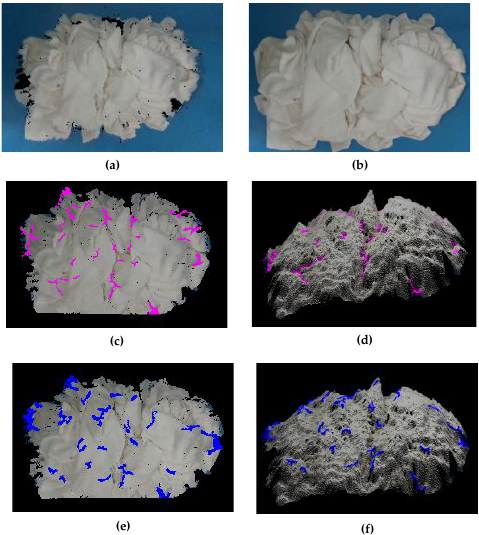
Figure 5. The concave and convex wrinkle: ( a ) the RGB image from Realsense D435; ( b ) the point clouds of the white square towels; ( c ) the concave wrinkle; ( d ) another viewpoint of ( c ); ( e ) the convex wrinkle; ( f ) another viewpoint of ( e